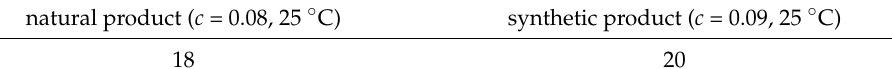
Table A2. Comparison of the spectral data among the synthetic and natural pterocarinin C ( 3 ), and the literature data reported by the Kawabata group